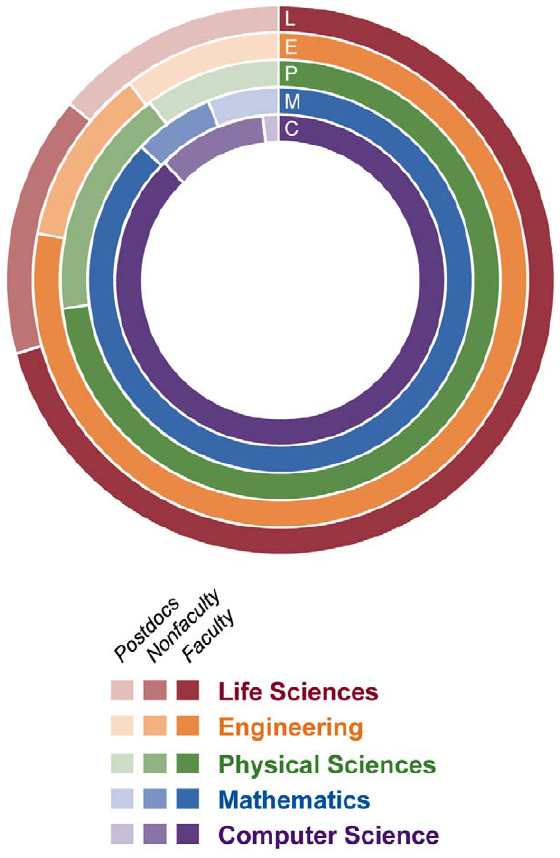
Figure 3. Science and Engineering Doctorate Holders Em- ployed in Academia in 2006. The proportion of full-time faculty (dark shade) was lowest for the life sciences (red) across all science and engineering fields in 2006. The life sciences also had the highest percentage of postdoctoral fellows (lightest shade) across all the fields. This was in contrast to computer science (purple), which had the highest proportion of full-time faculty and lowest proportion of postdoctoral fellows. SOURCE: National Science Foundation, Science and Engineering Indicators 2010.